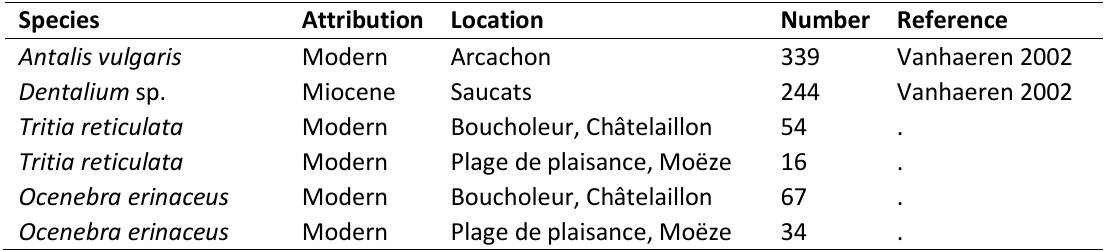
Table 1 : Modern and fossil reference collections used for the analysis of the shells of